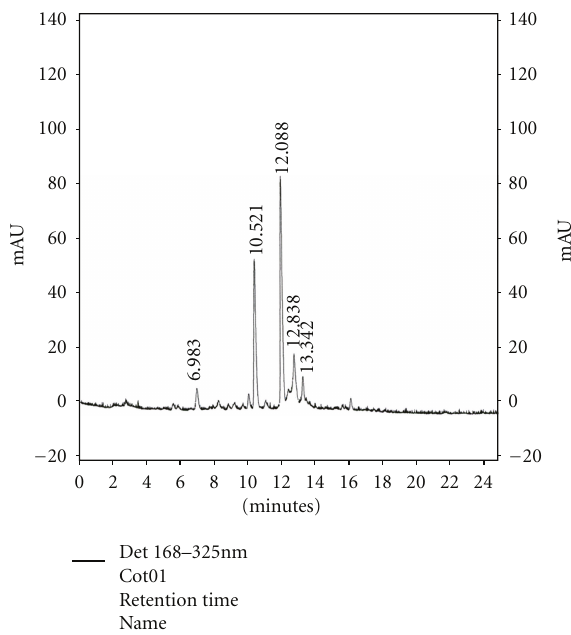
Figure 1: HPLC fingerprint of leaf methanol extract of Cotyledon